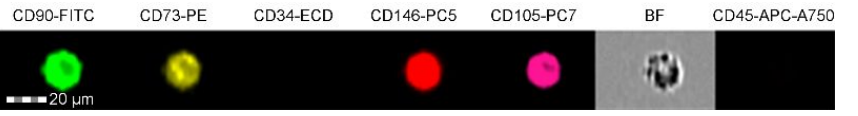
Figure 2. Single stem cells, antigens (CD90, CD73, CD146, CD105 positive and CD34, CD45-negative). Photographs of single samples of cells, presenting microscope image (BF) and fluorescence in channels, showing the expression of studied antigens (FlowSight f. Amnis flow cytometer).